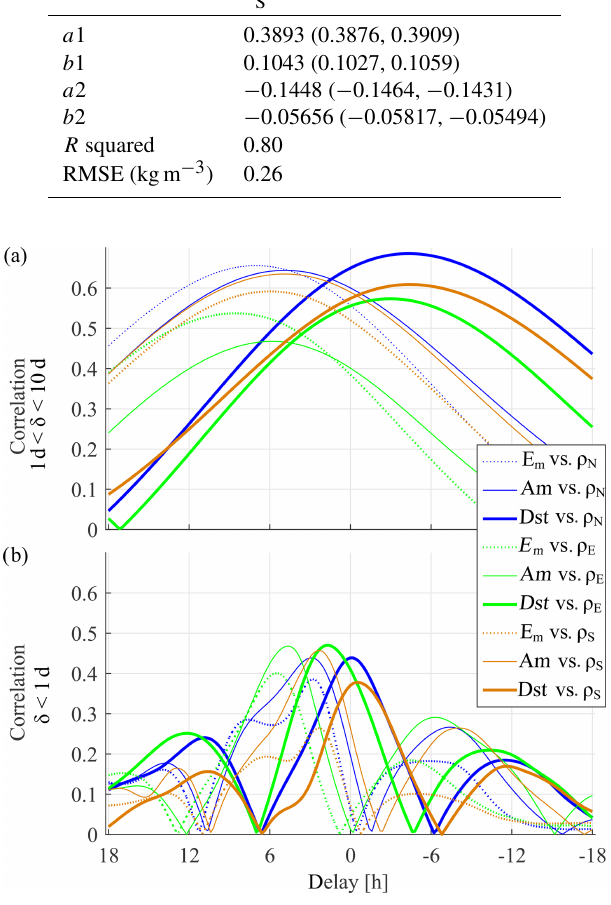
Figure 5. Delay/correlation between residual density disturbances at an altitude of 475km ( ρ r ) and the parameterizations of distur- bances in terms of E m , Am , and Dst indices, for (a) periods be- tween 1 and 10d and (b) sub-daily periods, for the northern ( ρ N ), equatorial ( ρ E ), and southern ( ρ S )